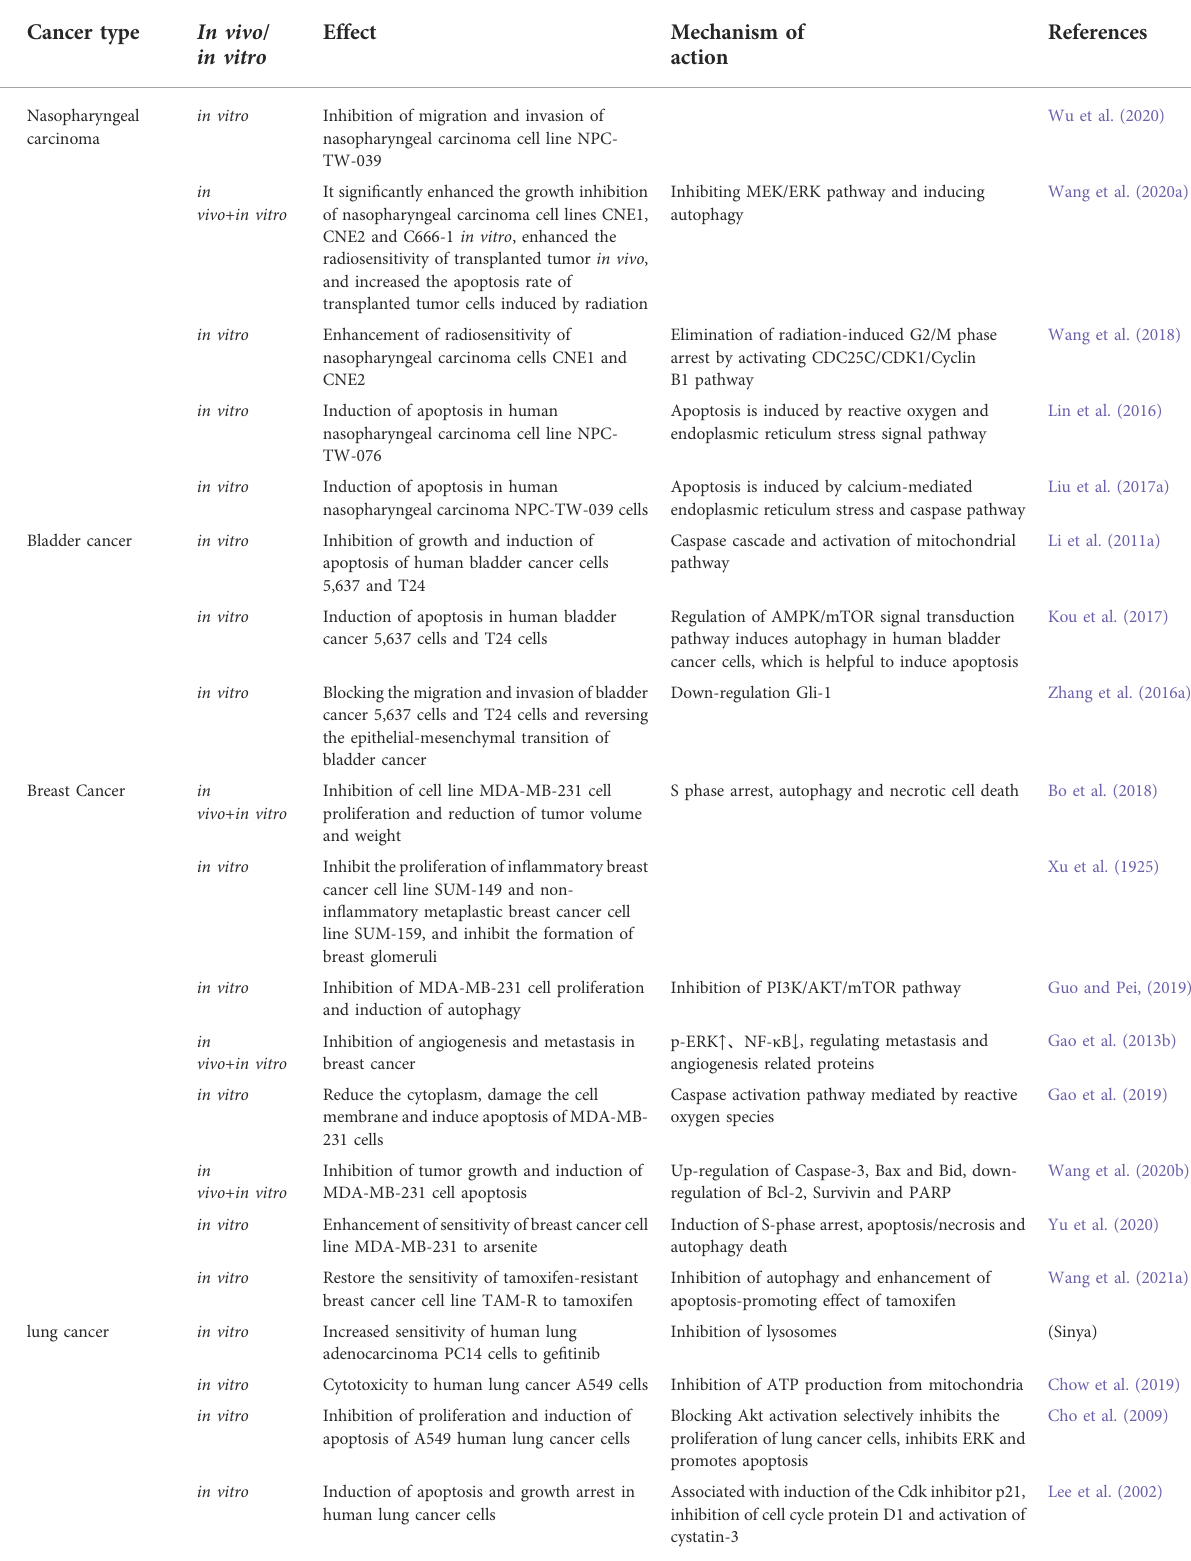
TABLE 1 Tet anti-tumor types and mechanism of